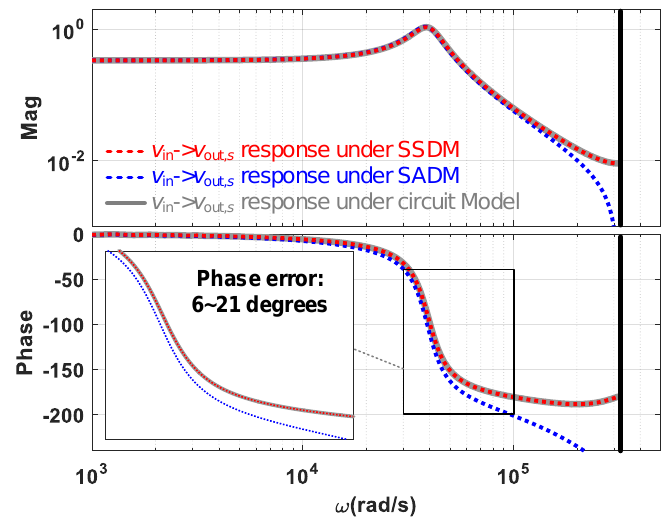
Energies 2020 , 13 , x FOR PEER REVIEW Figure 12. Frequency response from v in to v out, s under the SSDM, SADM, and circuit model.